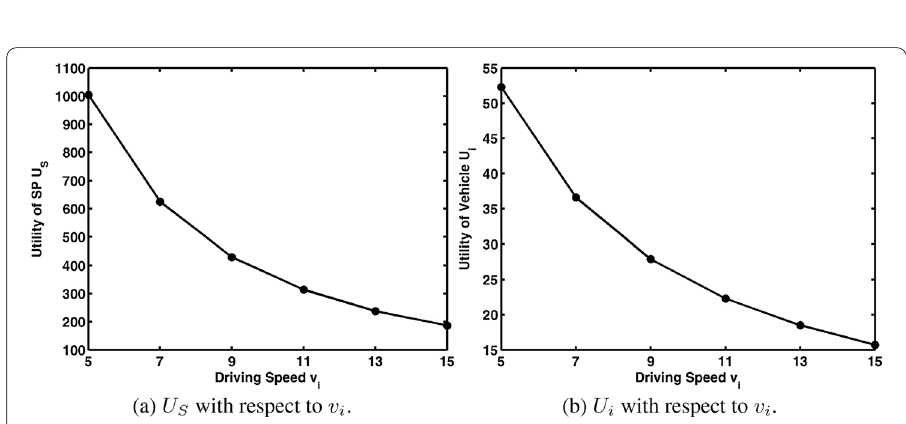
Fig. 9 The performance of incentive mechanism with respect to the velocity of